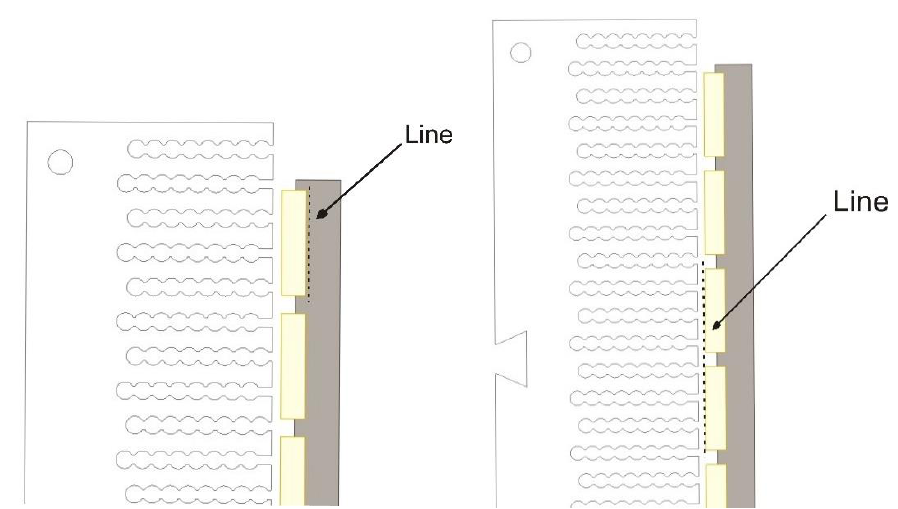
Figure 4. To find the requested values at each time-step, an additional mesh-line has been included in the simulation, illustrated above.